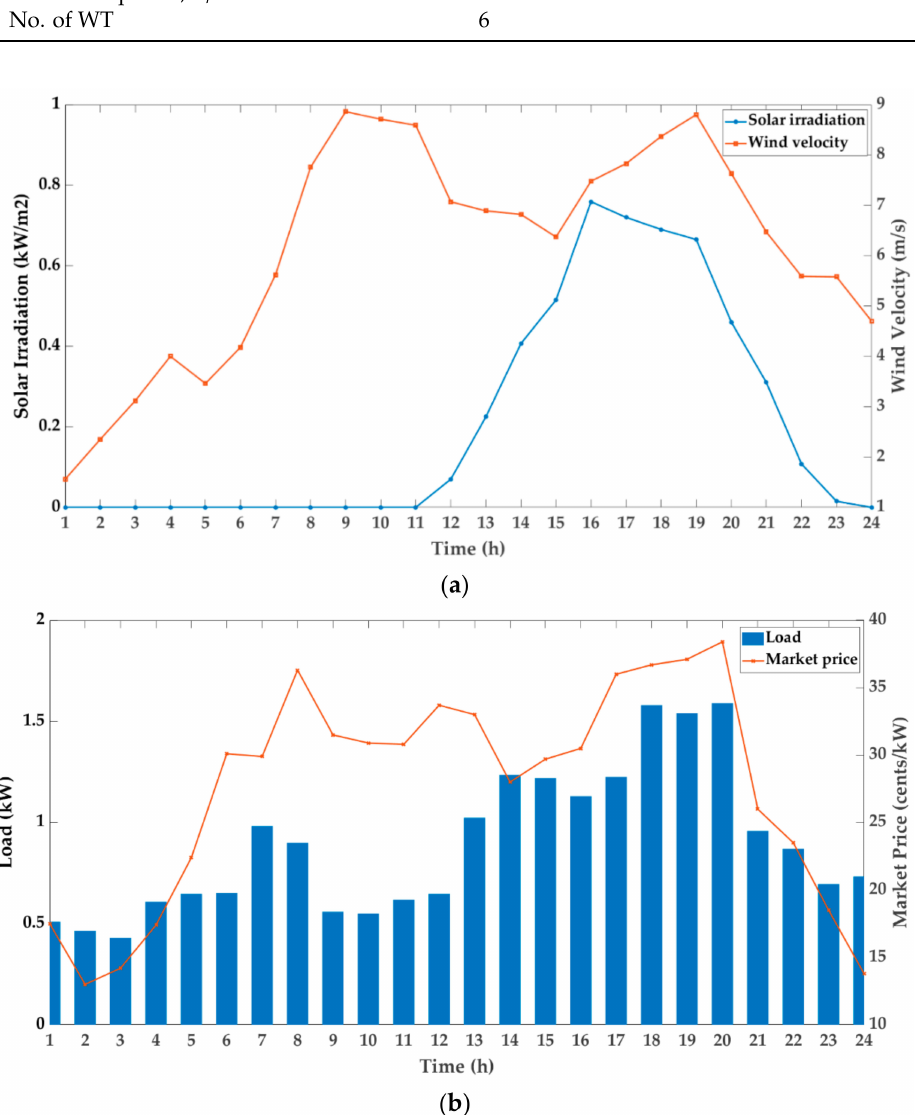
Figure 4. Input data over a 24 h horizon. ( a ) Wind velocity and solar irradiation. ( b ) Power load and market